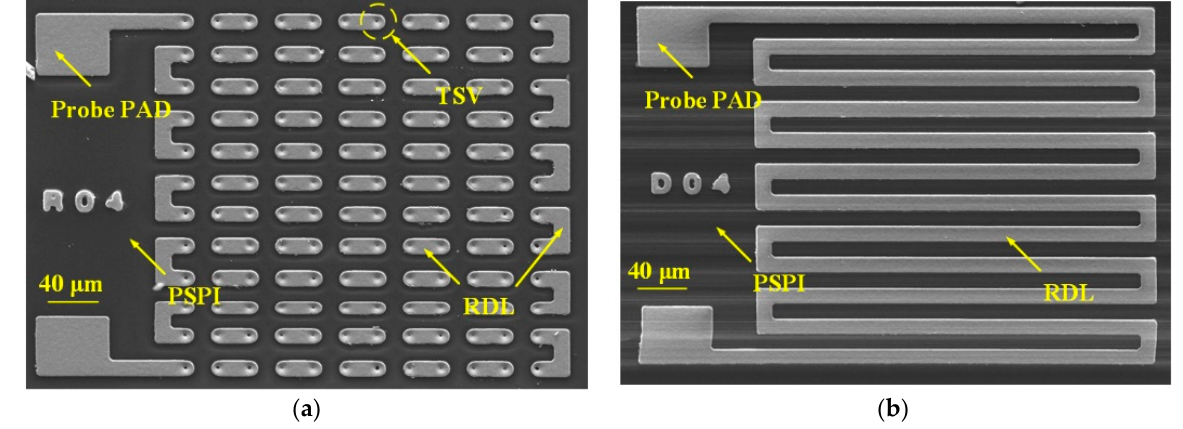
Figure 12. SEM images of the test structures for the DC resistance of the PI-TSV: ( a ) daisy chain structure, ( b ) decoupling structure.